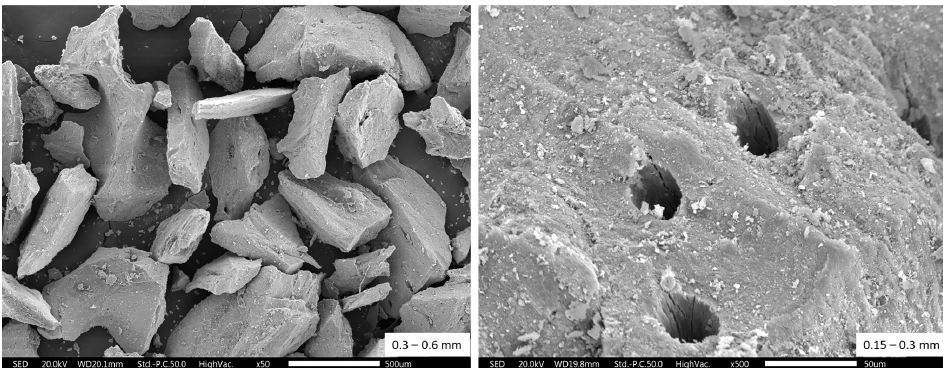
Figure 1. Scanning electron microscopy (SEM) images of the bonechar at two particle sizes: 0.3–0.6 mm and 0.15–0.3 mm at 50 × and 500 × magnifications,